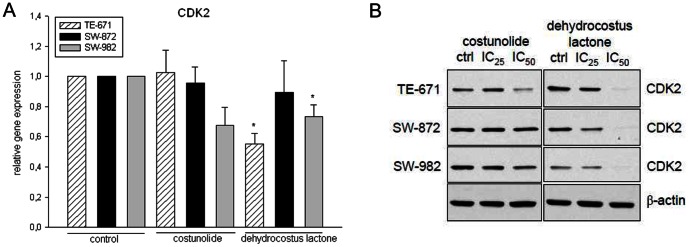
Relative mRNA expression and Western blot analysis of CDK2.A) Dehydrocostus lactone decreased the CKD2 mRNA expression levels significantly in SW-982 (*p = 0.041) and TE-671 (*p = 0.007) cells. B) This downregulation was also found on the protein level. No significant alteration could be observed after costunolide treatment. β-actin was used as loading control. Data shown are representative from at least three independent experiments.